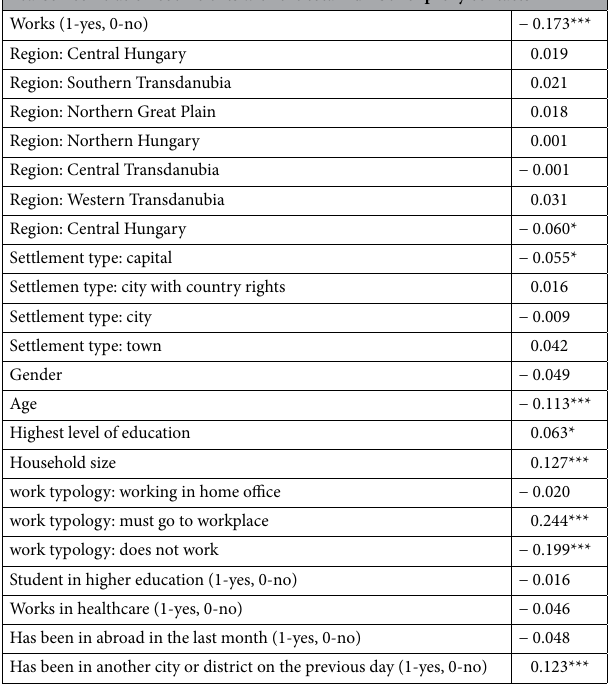
Table 1. Pearson Correlations Coefficients between the total number of proxy contacts of respondents in the representative survey and variables capturing their socio-demographic and life-style characteristics. Stars (*) indicate the level of significance. p < 0.05, ** p < 0.01, *** p <